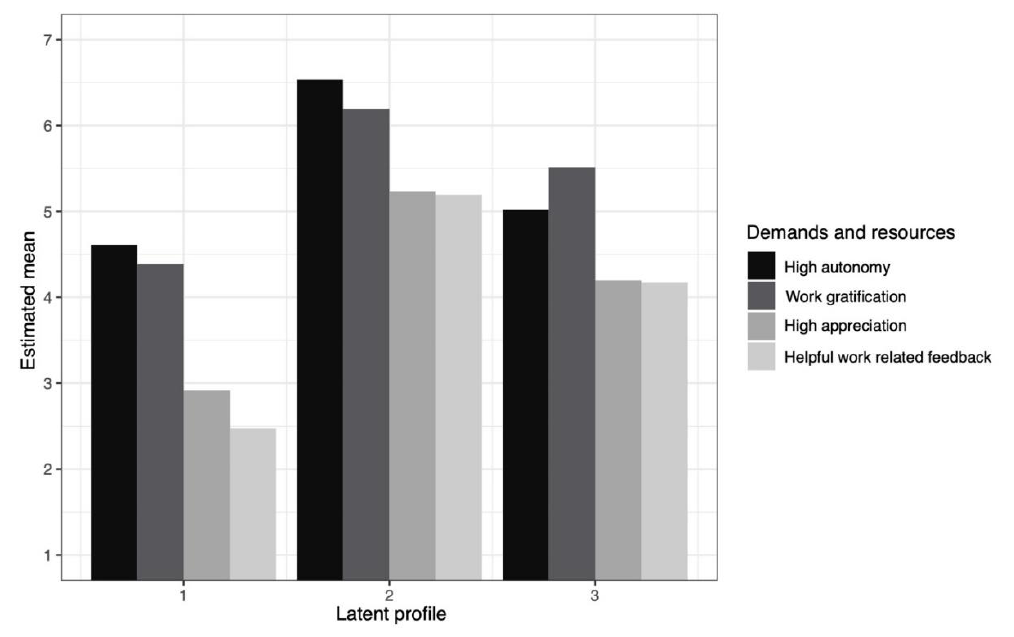
Figure 10. Latent profile solution for demands and resources (estimated means: high autonomy, work gratification, high appreciation, helpful work-related feedback; 7-point Likert scales; 1= never to 7= always/every